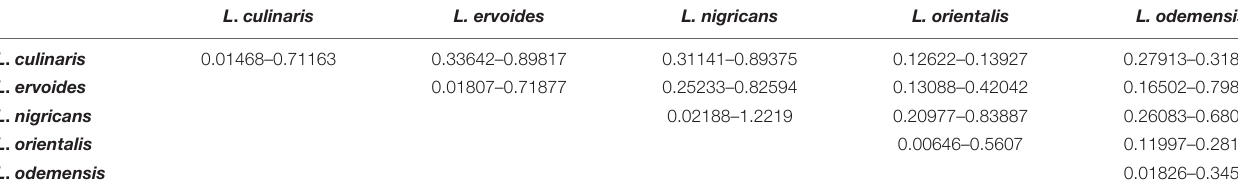
FIGURE 2 | Unweighted neighbor joining dendrogram generated based on genetic distance calculation from StAMPP in R. TABLE 4 | Ranges of Nei’s coefficient values within and amongst different lentil